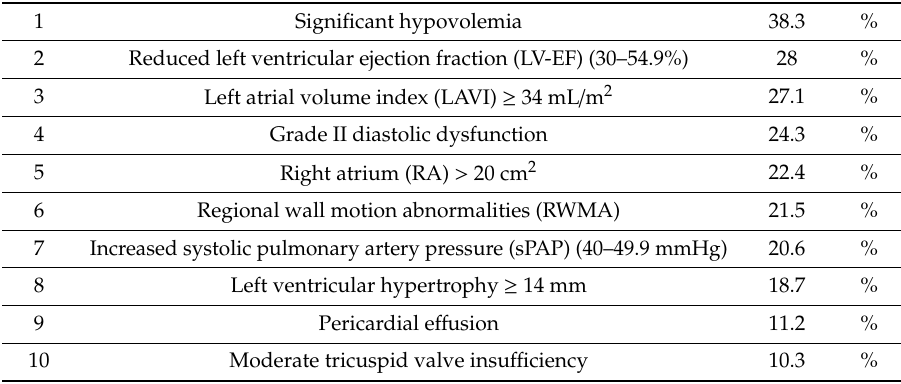
Table 2. The ten most frequently observed significant cardiac pathologies.